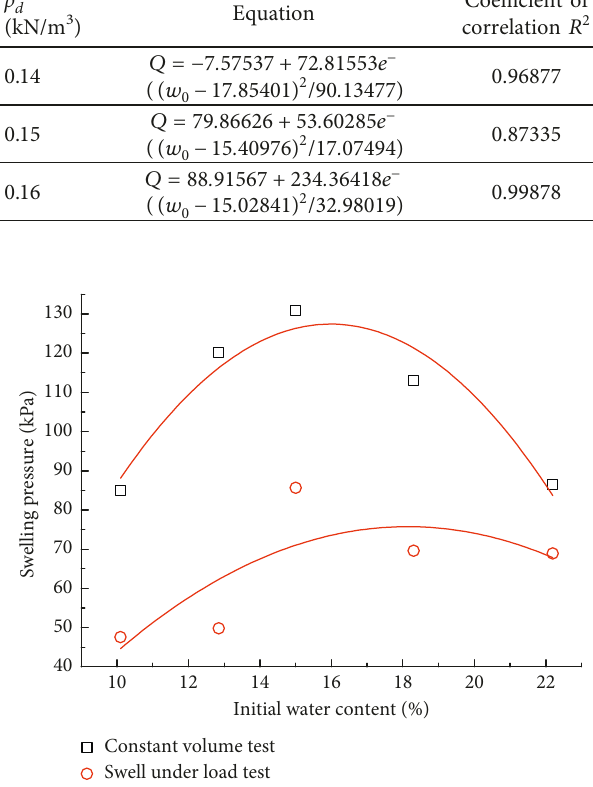
Figure 19: Relation between expansive stress and initial water content for two diverse stress paths.